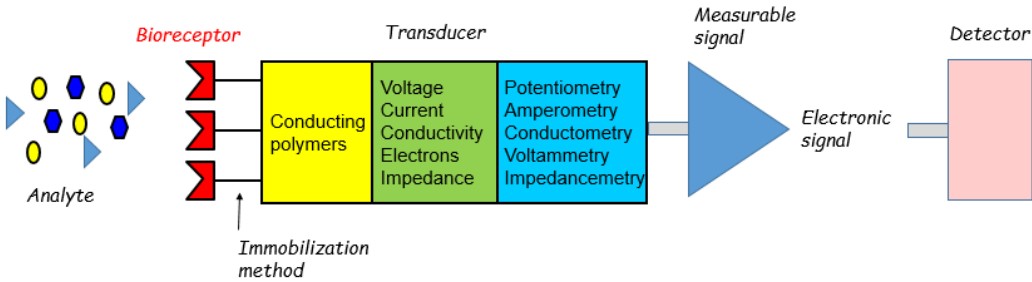
Figure 2. Detection principles of conducting polymer-based electrochemical biosensors.